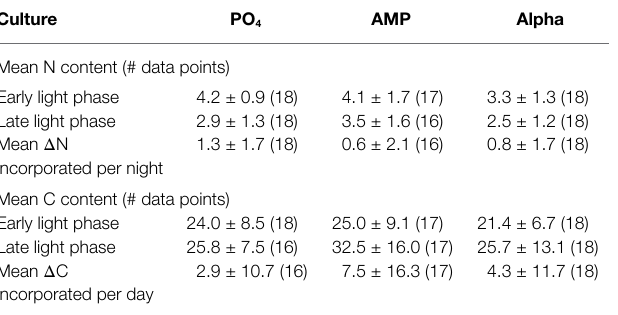
organic [mono phosphate adenosin (AMP), DL- α -glycerophosphate (Alpha)] source of phosphorus for growth. N and C contents were measured in the early and late light